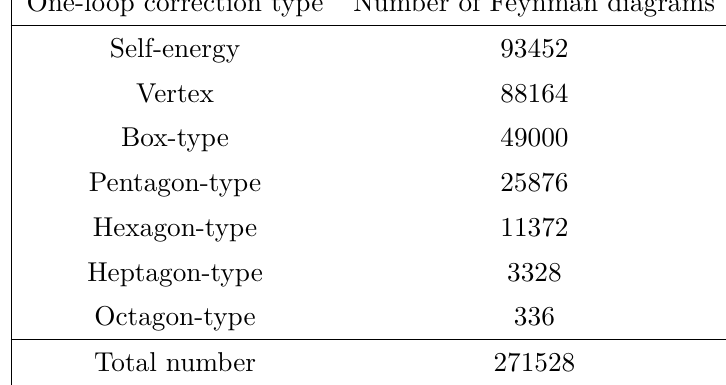
The number of one-loop Feynman diagrams for the dominant subprocess gg